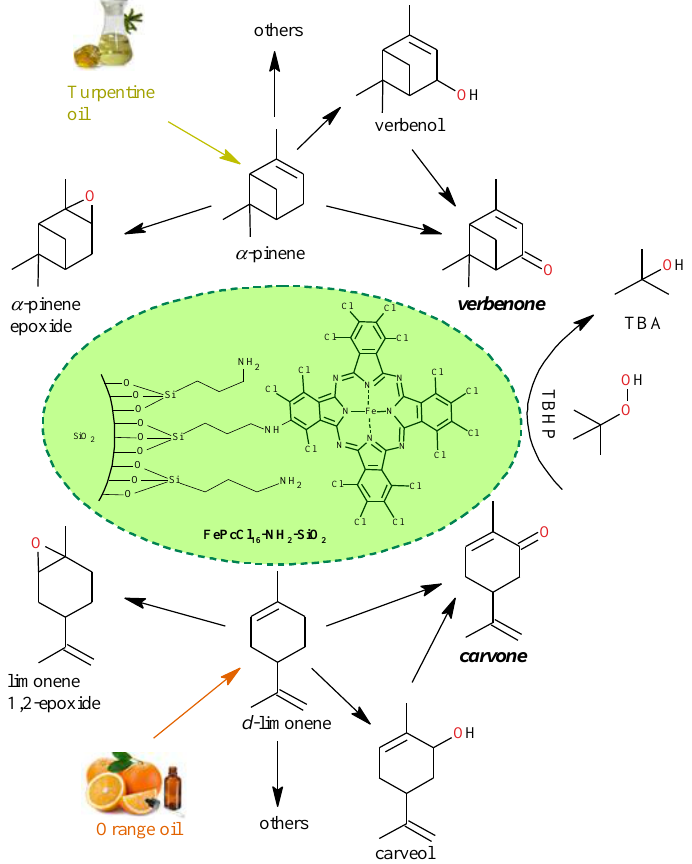
Figure 1. Chemical route for the production of verbenone and carvone from α -pinene and d -limonene oxidation with TBHP and FePcCl 16 -NH 2 -SiO 2 . Conditions: acetone, 40–50 ◦ C, 6 h, molar ratio TBHP/monoterpene of 2.6:1. TBA: t-butyl alcohol.